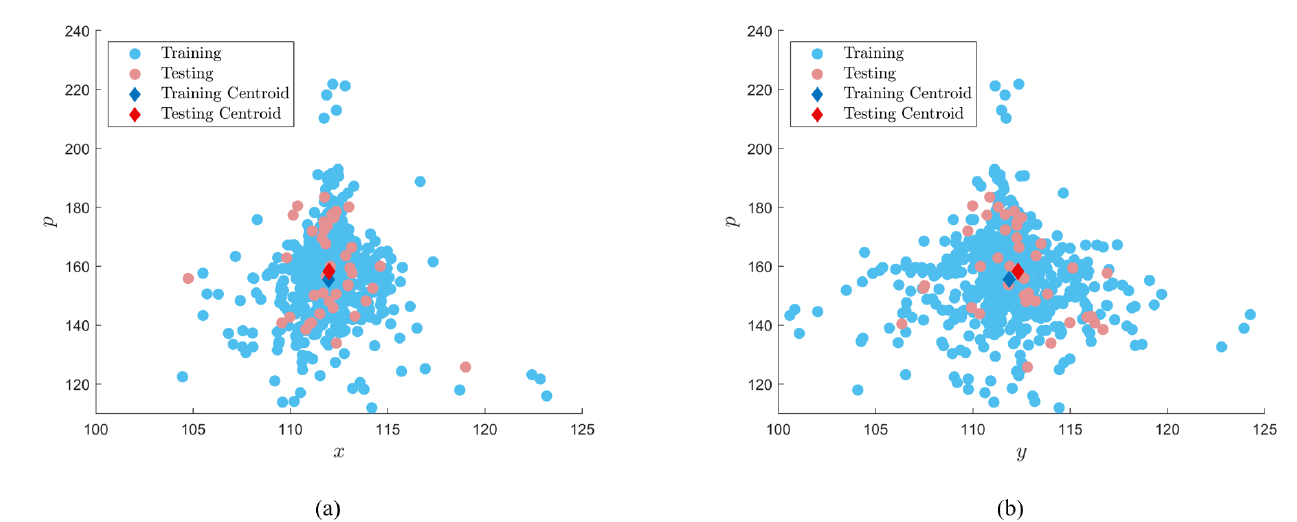
Figure 8. Clustering of training and testing datasets along ( a ) x-direction and ( b ) y-direction for the class